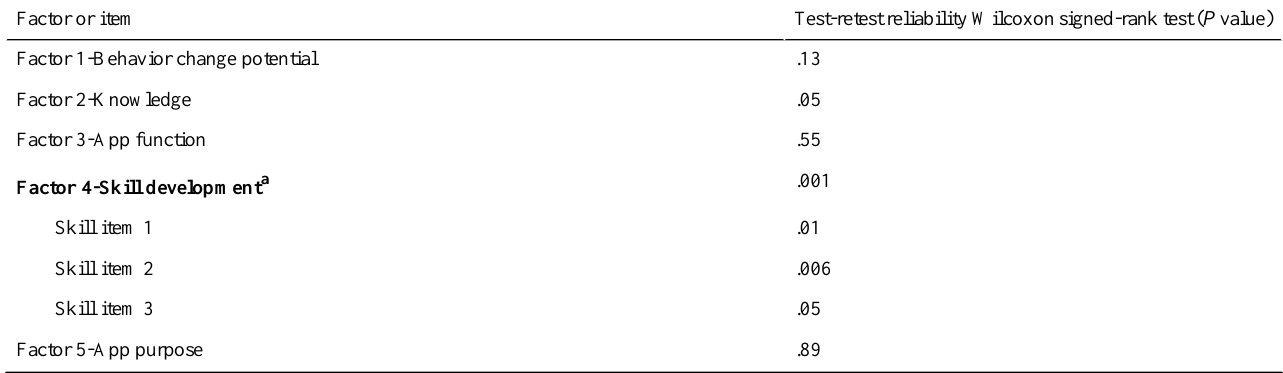
Table 3. Test-retest reliability of factors of the app quality evaluation (n=75 evaluations).